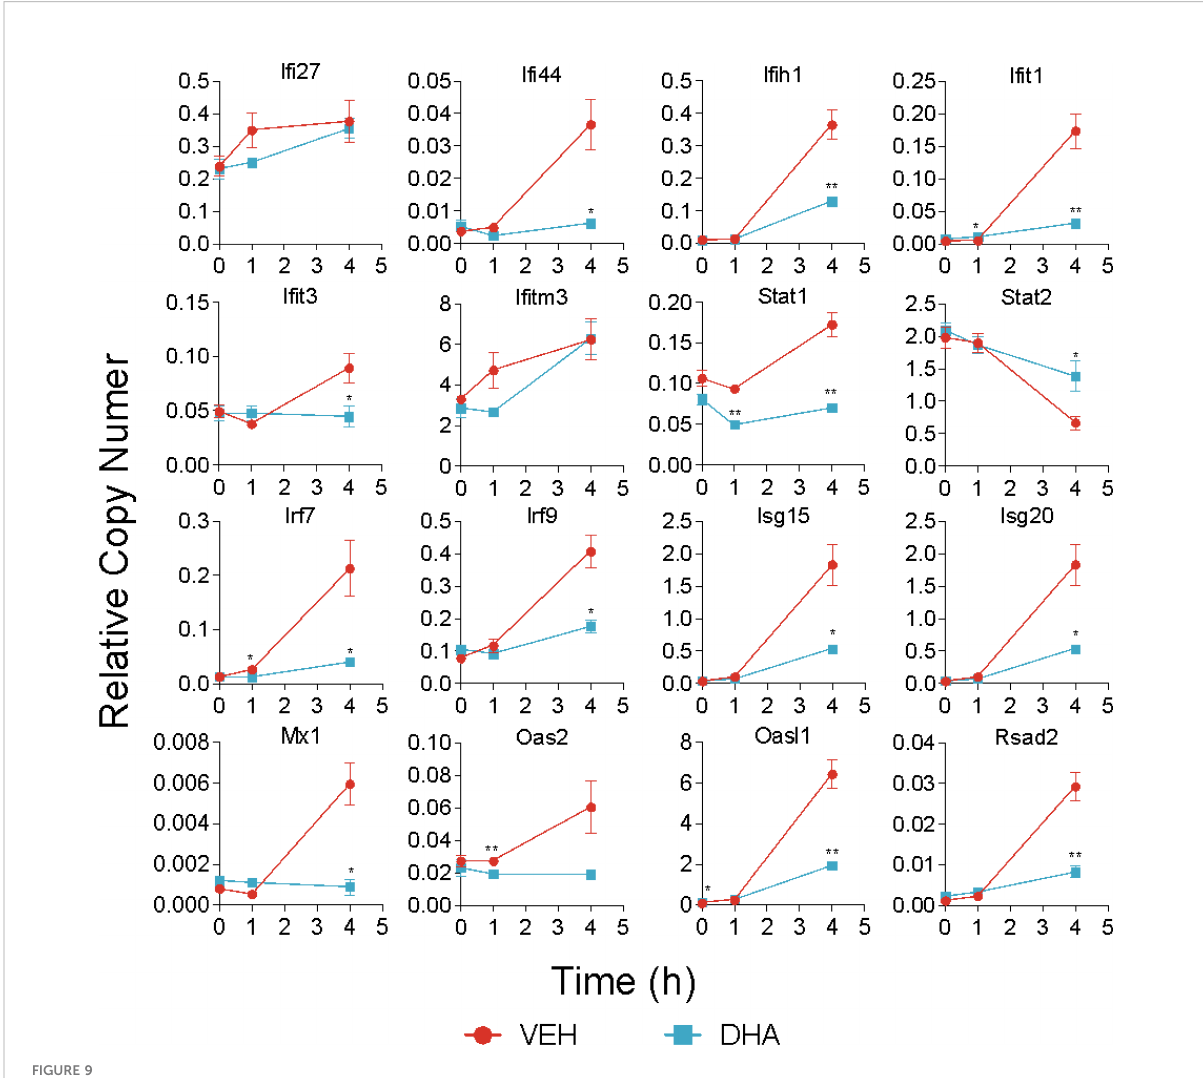
FIGURE 9 DHA suppresses expression of selected IFN1-regulated genes. A panel of IFN1-regulated genes was investigated by bulk qPCR in samples treated with LPS for 1 and 4 h. Cells were pre-treated with DHA or Veh for 24 h prior to LPS treatment. Asterisks indicate signi fi cant differences (* p <0.05, ** p <0.01) between the DHA and Veh groups,